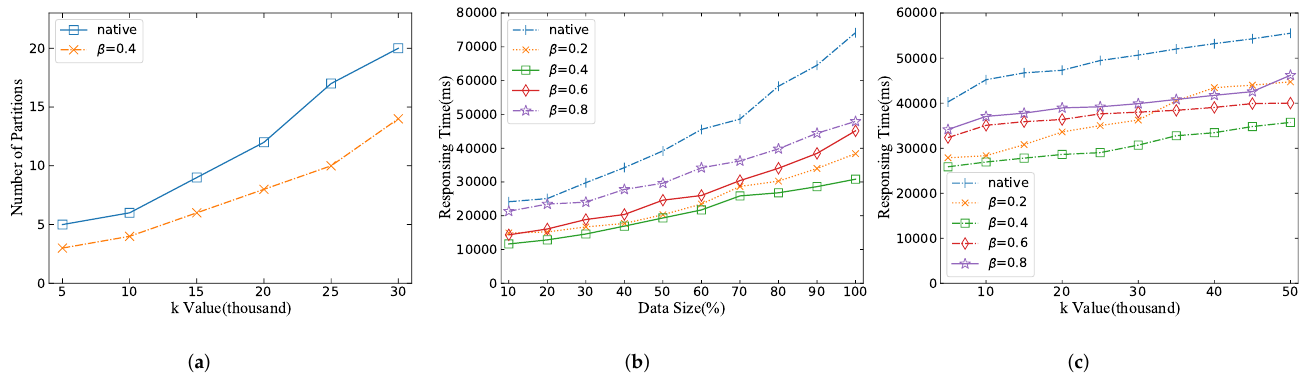
Figure 12. Performance of AIRO algorithm. ( a ) depicts the comparison of the number of partitions for the native algorithm and the optimized algorithm as the value of k increases; ( b ) shows the impact of the range radius factor β on response time for different dataset sizes; and ( c ) indicates the influence of β on response time under different k values. The different values of β reveal how the radius of the iteration range changes. The larger the value of β , the faster the growth rate of the iteration range radius. ( a ) Data size. ( b ) K -value. ( c ) Time